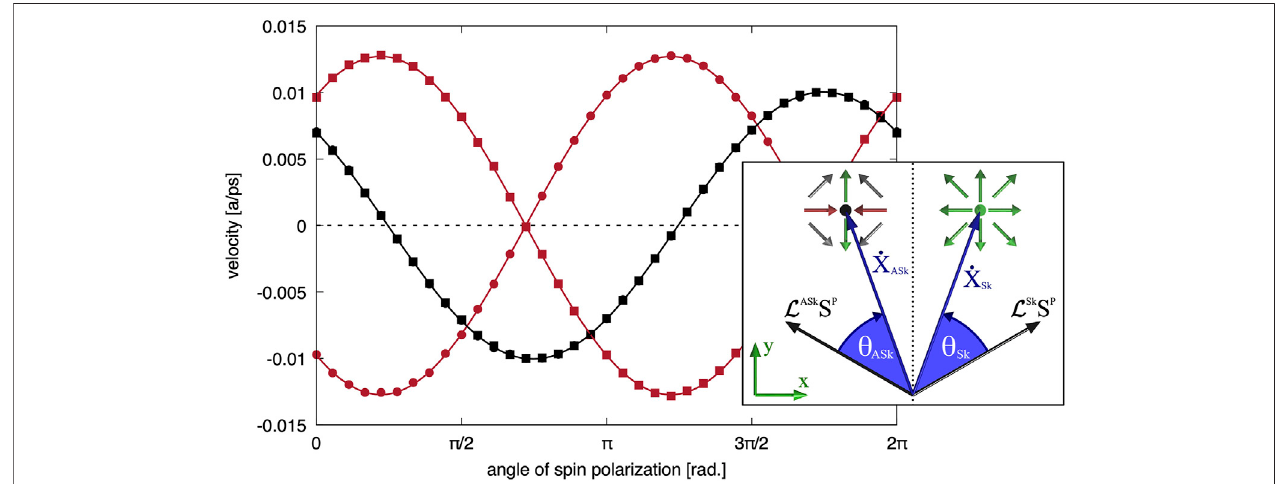
FIGURE5| Velocitycomponentsalong x -direction(red)and y -direction(black)fordifferentorientationsofthespincurrentpolarization(anglemeasuredfromthe x - axis). Circles (squares) represent the skyrmion (antiskyrmion). Inset: schematic representation of the resulting trajectories of skyrmions and antiskyrmions and their symmetry relation according to the Thiele-like Eq. 6